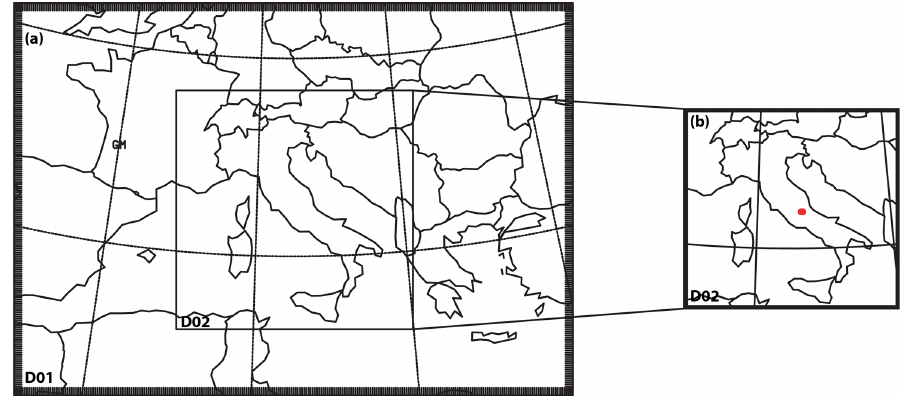
Figure 4. Model configuration for WRF simulations using two domains: (a) overlapping of 12 and 3km; (b) the high-resolution D02 ( 1x = 3km) includes the Monte Midia radar (red dot in the figure).